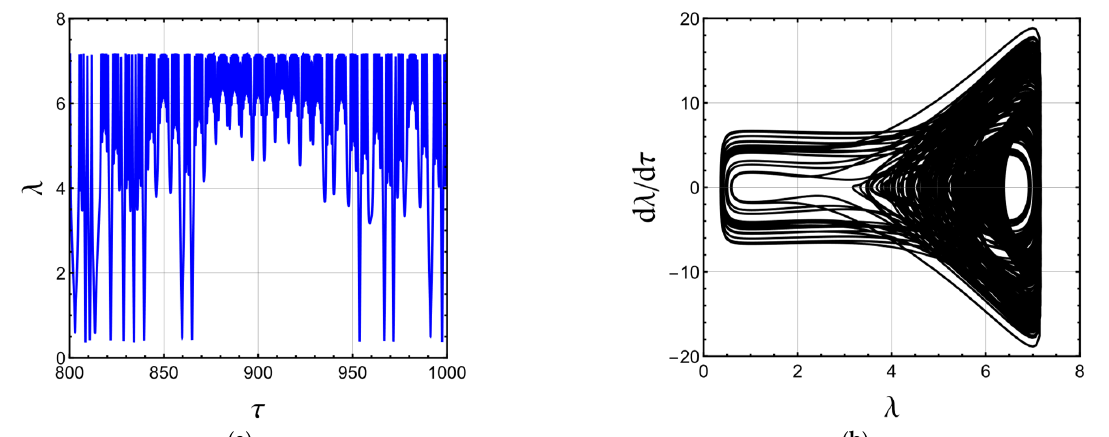
(cid:3009)(cid:3365) (cid:3136) (cid:3404) 0.5. ( a ) Time history (cid:3009)(cid:3365) (cid:3151) H S